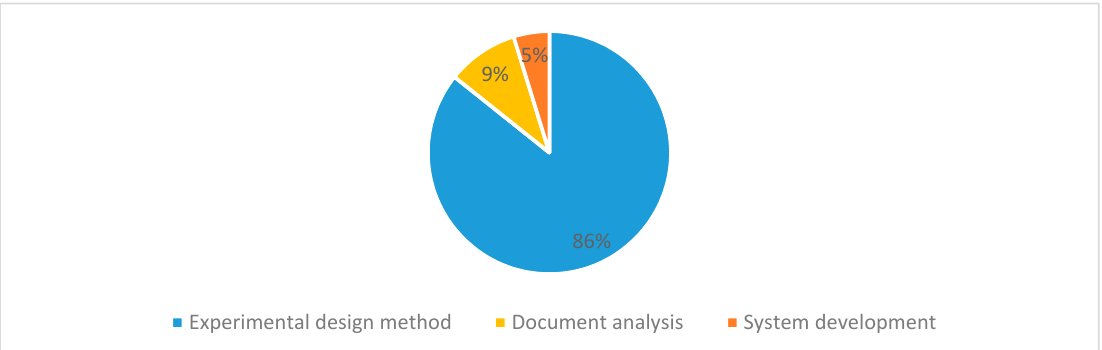
Figure 12. The percentage of three research methods.